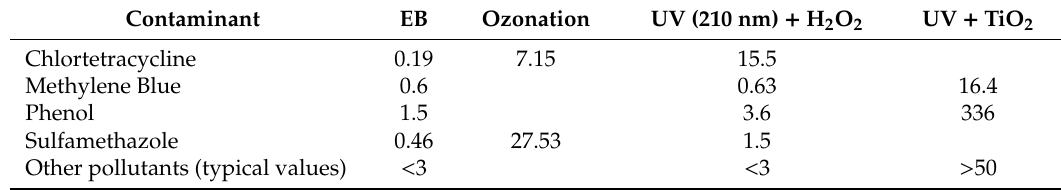
Table 10. EE / O values for the decomposition of solute contaminants by di ff erent ATPs. Contaminant EB Ozonation UV (210 nm) + H 2 O 2 UV + TiO 2 Chlortetracycline 0.19 7.15 15.5 Methylene Blue 0.6 0.63 16.4 Phenol 1.5 3.6 336 Sulfamethazole 0.46 27.53 1.5 Other pollutants (typical values) < 3 < 3 >